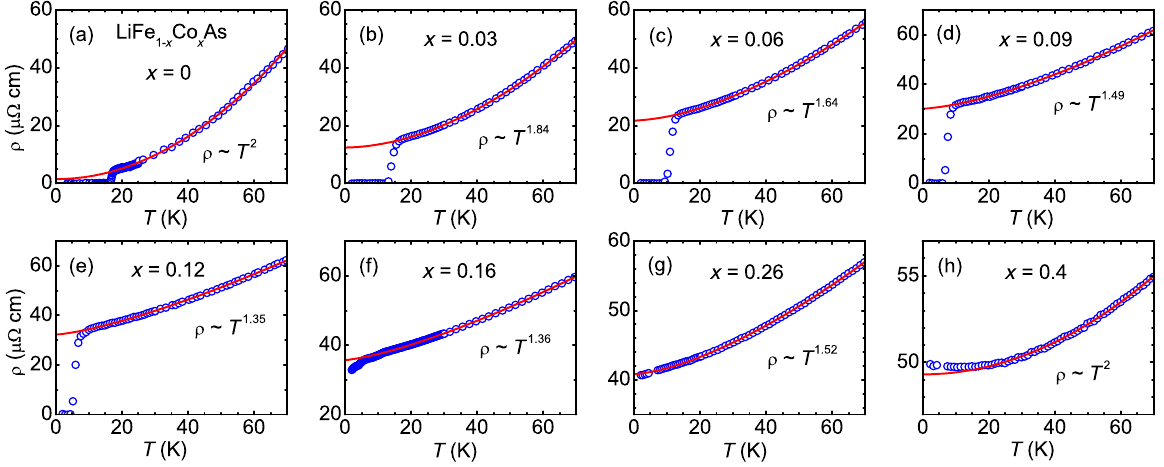
FIG. 5. (a) – (h) Resistivity of LiFe 1 − x Co x As as a function of temperature for different Co values. For each sample, the resistivity curve is fit to the single power-law expression ρ ð T Þ ¼ ρ 0 þ AT n . The open circles denote the measured resistivity and the solid lines in each panel are the fitting results. The power n derived from the fitting is shown in each